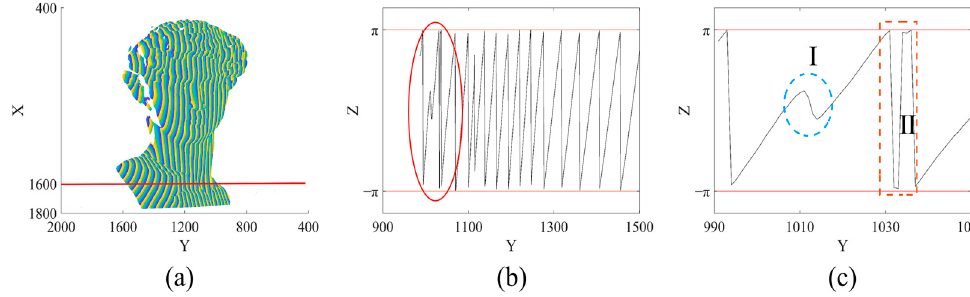
Figure 2. PUE caused by wrapped phase error: ( a ) Wrapped phase map; ( b ) Wrapped phase map on the section of X = 1600; ( c ) Enlarged sub-image in ( b on the section of X = 1600; ( c ) Enlarged sub-image in ( b ).